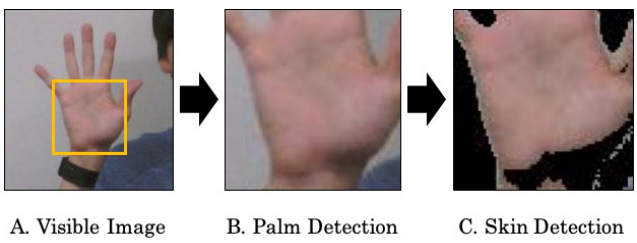
Figure 5. Palm region